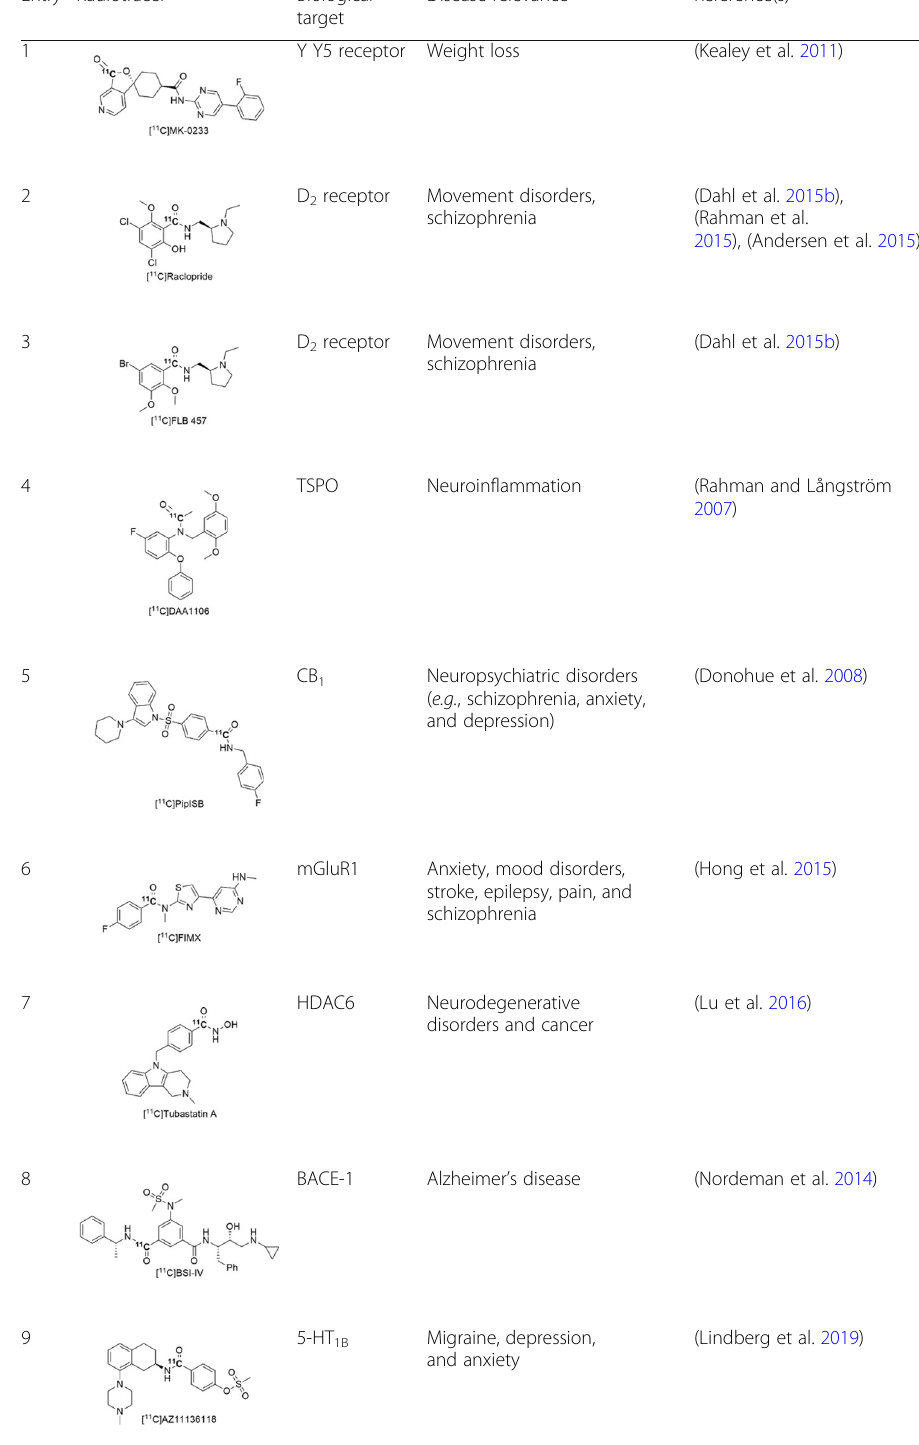
Table 1 Radiotracers radiolabeled using [ 11 C]carbon monoxide, the corresponding